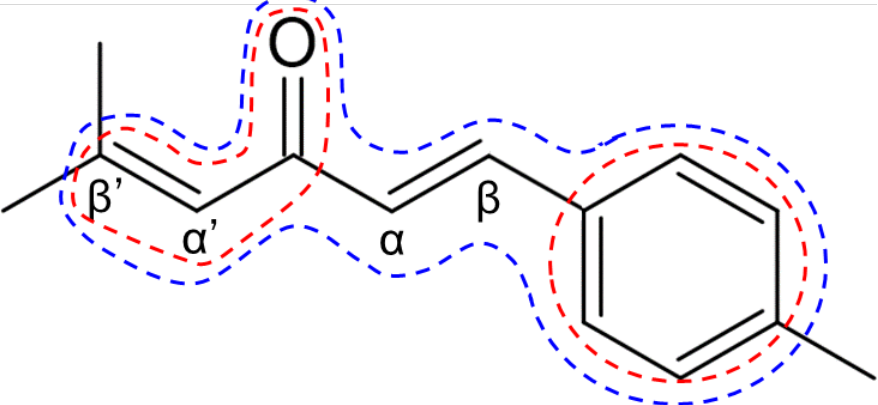
Figure 8. Structure − activity relationship of ar-turmerone analogs. The chemical structure of A2 with indications of α - , β - , α’ -, and Figure 8. Structure-activity relationship of ar-turmerone analogs. The chemical structure of A2 β’ -carbons from the carbonyl base. Red and blue lines represent the regions involved in the anti-inflammation in BV2 cells and Nrf2 with indications of α -, β -, α ’-, and β ’-carbons from the carbonyl base. Red and blue lines represent activation in LUHMES cells, respectively. the regions involved in the anti-inflammation in BV2 cells and Nrf2 activation in LUHMES cells,